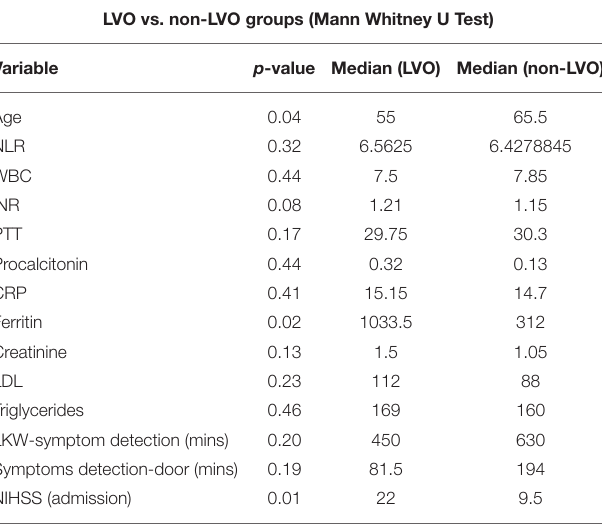
TABLE 4 | Comparison between LVO vs. non-LVO (Mann Whitney U-test). LVO vs. non-LVO groups (Mann Whitney U